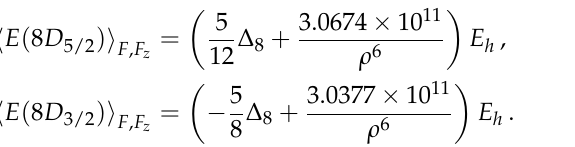
Table 3. Second-order van-der-Waals shifts of the 1/ R 6 -type are given for 8 D j hydrogen atoms interacting with 2 S -state hydrogen atoms in the presence of virtual P states. Just as in Table 2, entries marked with a long hyphen (–) indicate unphysical combinations of F and F z values. The interatomic distance in atomic units is denoted as ρ = R / a 0 . All energy shifts are given in Hartrees. The quantity ∆ 8 constitutes the fine-structure-hyperfine-structure mixing term, which is given in Equation